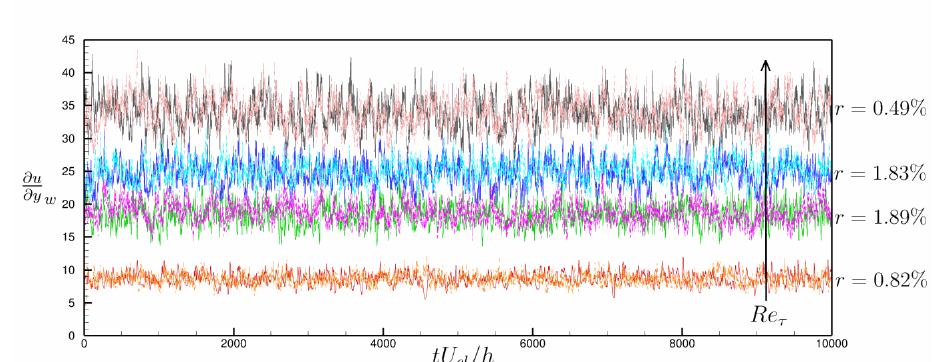
Figure 2. Time series of area-averaged wall shear rates for MFU (solid lines) and SD (dashed lines) in an extended domain at Re τ = 200,500,700,1000. Both time series are nearly indistinguishable, indicating that mean and fluctuation characteristics agree quite well. Note that r is the percent difference of the root-mean-square wall shear rates between MFU and SD.